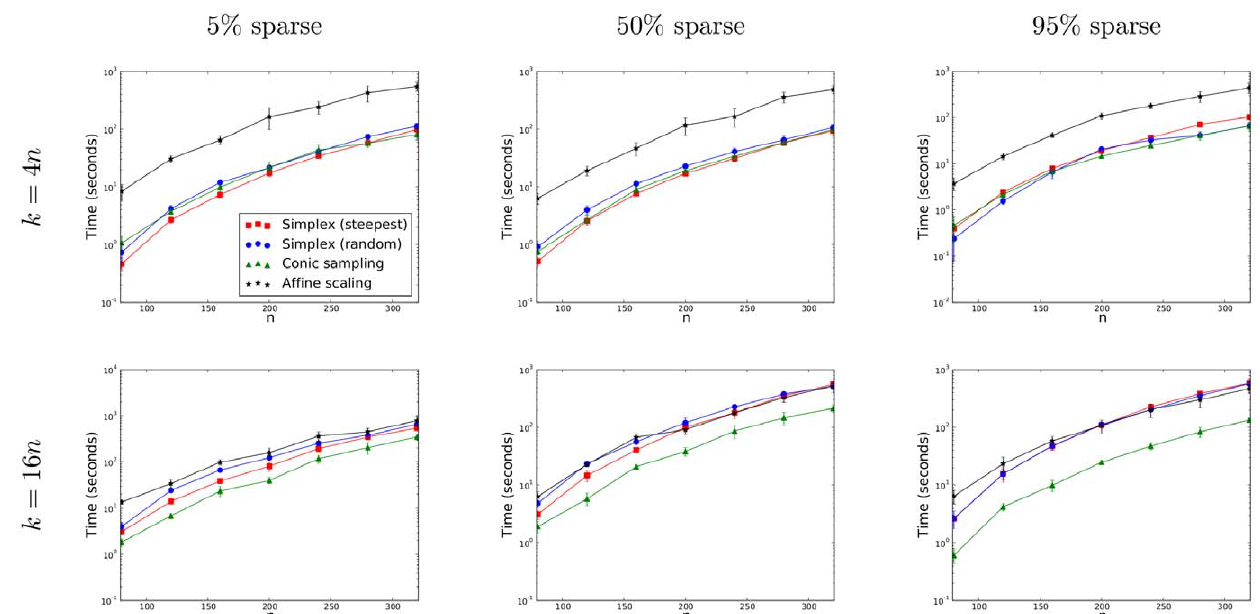
Figure 2. Preliminary runtime analysis on random LPs. The simplex and affine-scaling algorithms are timed against the conic sampling algorithm on random LP problems of varying dimension n and number of constraints k =2 n and 16 n . For each n and k , five LP problems were generated. Each panel figure plots the mean runtime as a function of . Error bars indicate the minimum and maximum runtimes. Dual sparse-dense vector data structures were used.